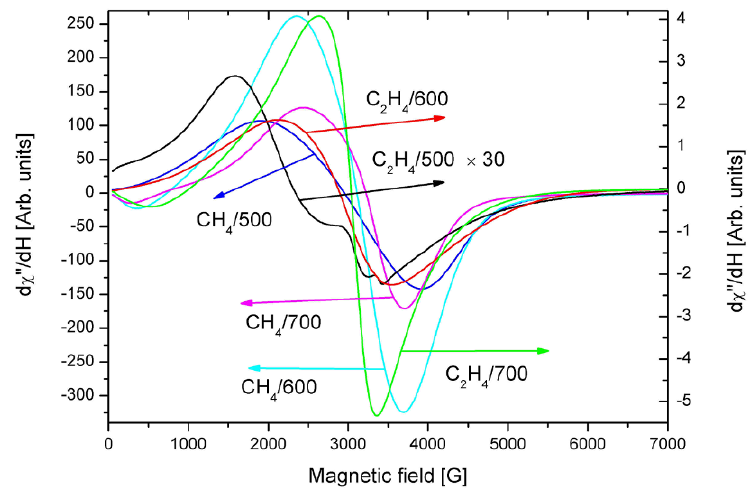
Figure 1. Magnetic resonance spectra of six investigated samples at room temperature rescaled to a unit mass. Due to a large difference in signals amplitudes the left and the right scales are used for three samples